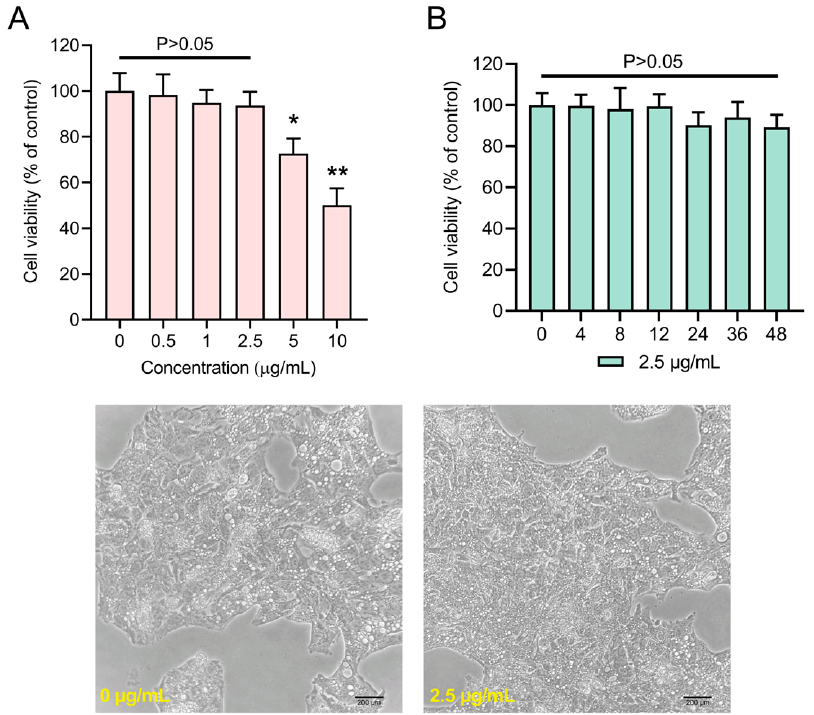
Figure 4. Cytotoxic effects of L. plantarum metabolites (LPM) in ( A ) dose- and ( B ) time-dependent manners. LPM was dissolved in cell culture media and treated against HepG2 cells. Lower panels represent HepG2 cells treated with or without LPM. Data represented as mean ± SEM of 6 measurements. * p < 0.05 and ** p < 0.01.